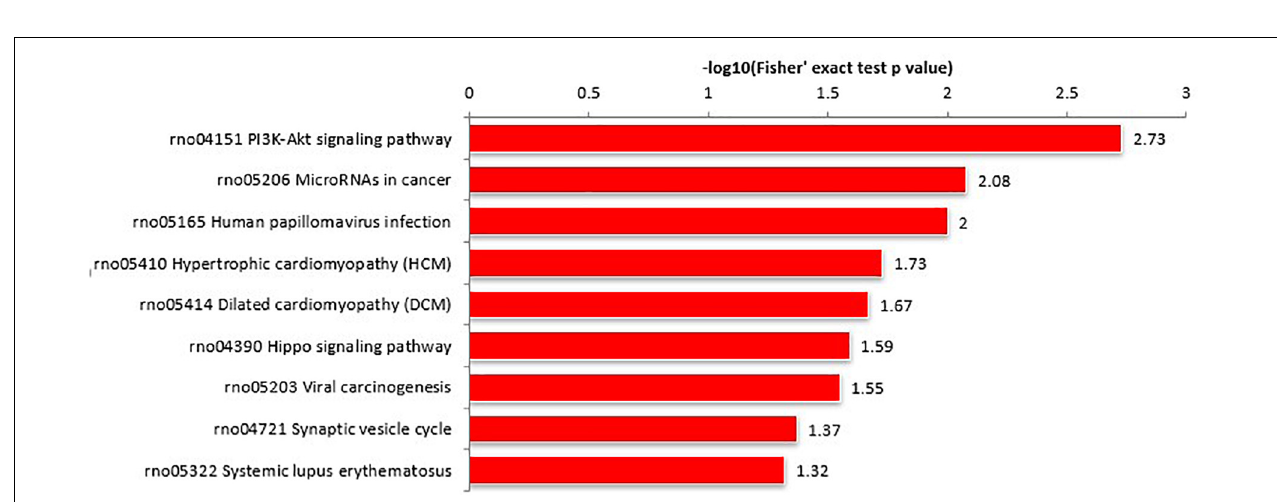
FIGURE 4 | KEGG pathway enrichment analysis of proteins differing in abundance between SE and Ctr groups. The ‘PI3K-Akt signaling pathway’ showed highest enrichment. These differentially abundant proteins were also enriched in ‘synaptic vesicle cycle pathway.’